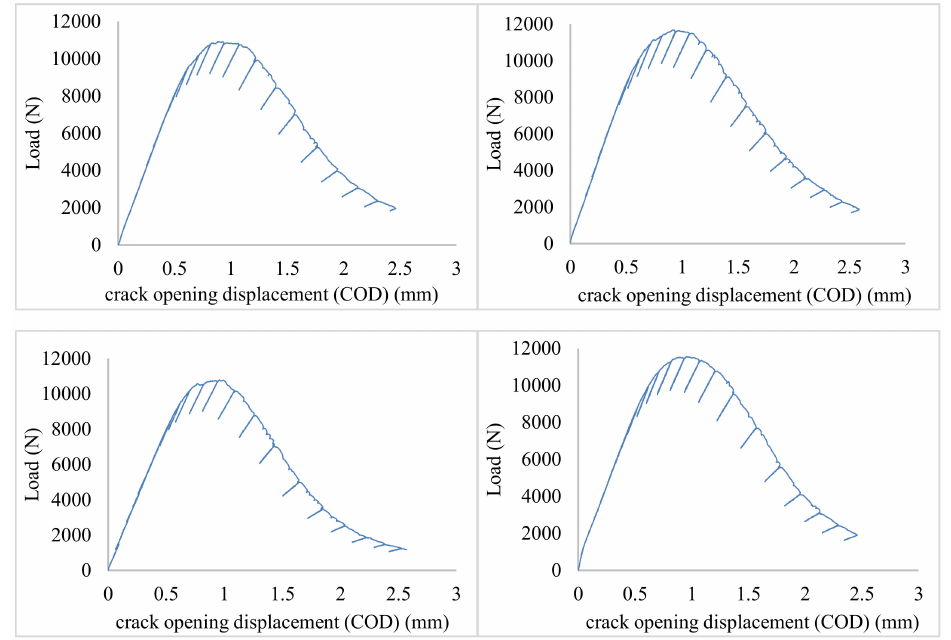
Figure 5. Force—COD curve in compact tension specimens for AA2519 tested under cryogenic conditions. Under cryogenic conditions, higher force values were recorded during subsequent